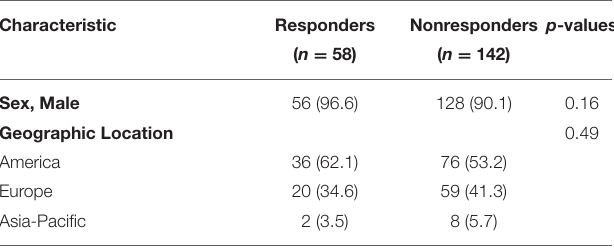
TABLE 2 | Evaluation for responder bias.